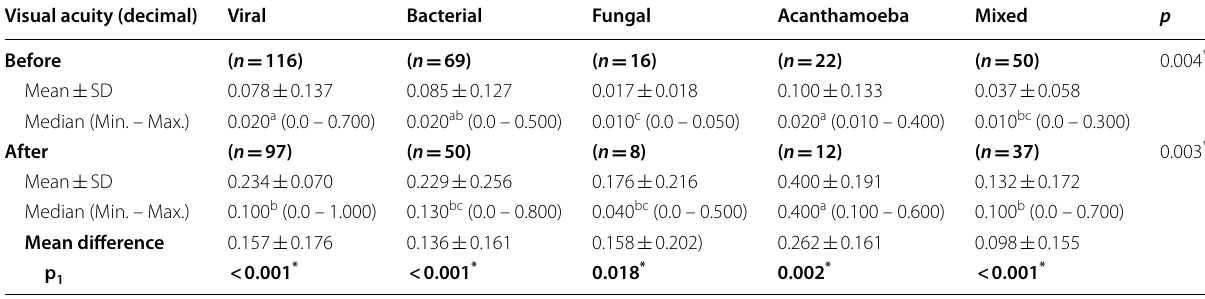
Numbers with different letters are significant MC Monte carlo, p : p -value for comparing between the studied groups * Statistically significant at p 0.05 p1: p -value for Wilcoxon signed ranks test for comparing between before and after in each group ≤